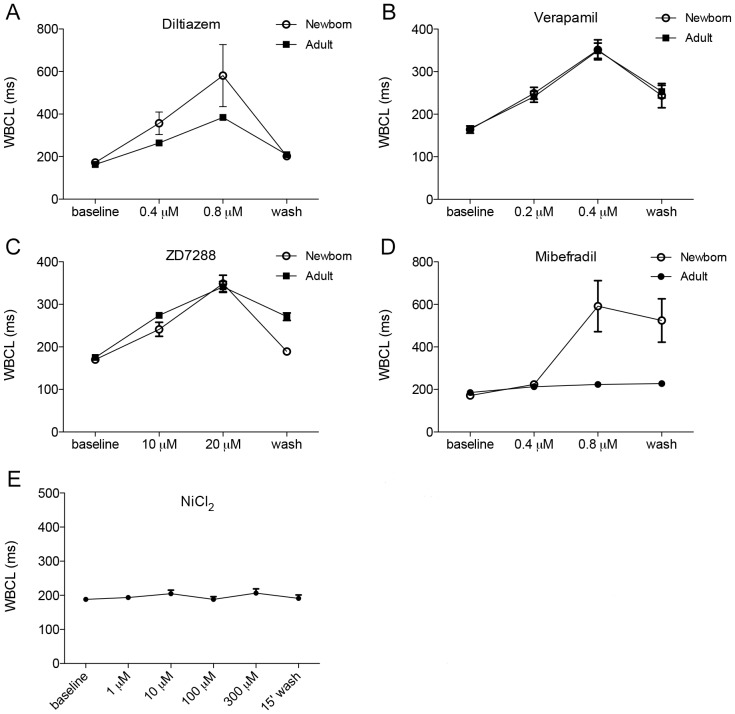
Ion channel blocker effects on Wenckebach cycle length in atrial paced newborn and adult rabbit hearts.Wenckebach cycle length (WBCL) was recorded during perfusion with calcium channel and I
f channel blockers in newborn and adult rabbit hearts (WBCL in milliseconds). Equivalent effects were observed in adult and newborn hearts treated with L-type calcium channel blockers (A) Diltiazem and (B) Verapamil and with the I
f blocker ZD7288 (C) (p = ns repeated measures ANOVA). The T-type calcium channel blocker Mibefradil (D) demonstrated significant preferential AV block in the newborn hearts as compared to the adult hearts (p<0.05). Values shown are mean ± SEM, newborn (n = 7) and adult (n = 8). Diltiazem showed a trend toward a difference in sensitivity of adult and newborn hearts, however there was great variability in results between experiments. (E) Effects of the α1H T-type calcium channel blocker NiCl2 were also investigated on WBCL in newborn Langendorff rabbit hearts. WBCL measurements do not differ from each other significantly with mean ± SEM (repeated measures ANOVA p = ns). One heart out of 6 that appeared to be an outlier showed some variability in response to NiCl2, and was excluded from statistical analysis.